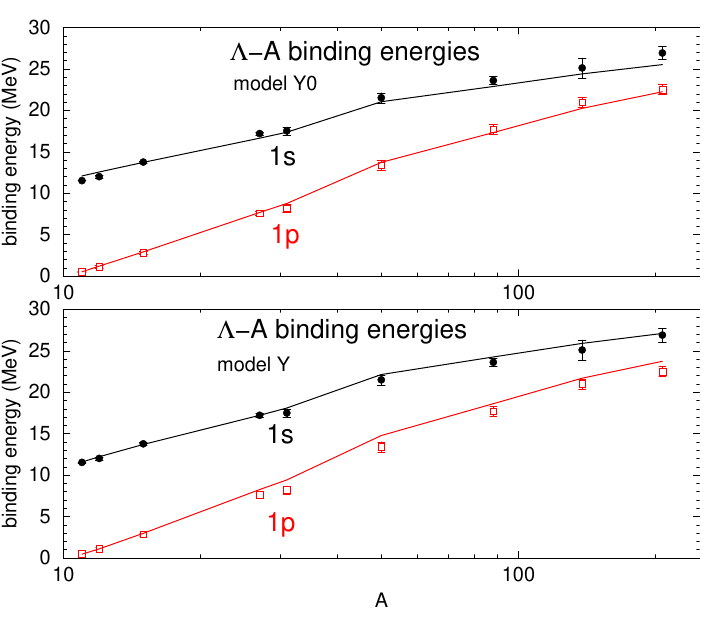
Figure 4. B 1 s , 1 p Λ ( A ) values from models Y0 and Y compared with data, see text. Continuous lines connect calculated